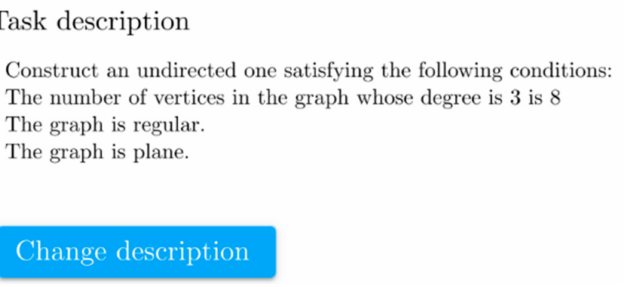
Figure 1. An example of choosing graph characteristics when creating a problem (the figure is taken from [43]).